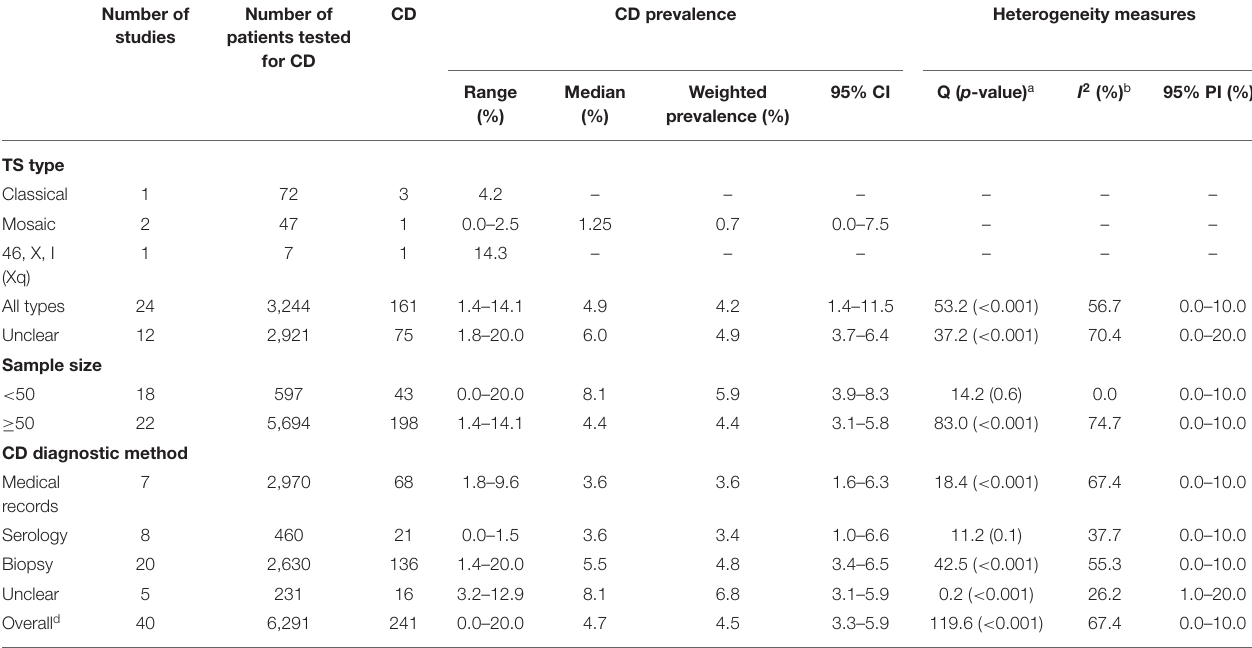
TABLE 2 | Weighted prevalence of CD in patients with